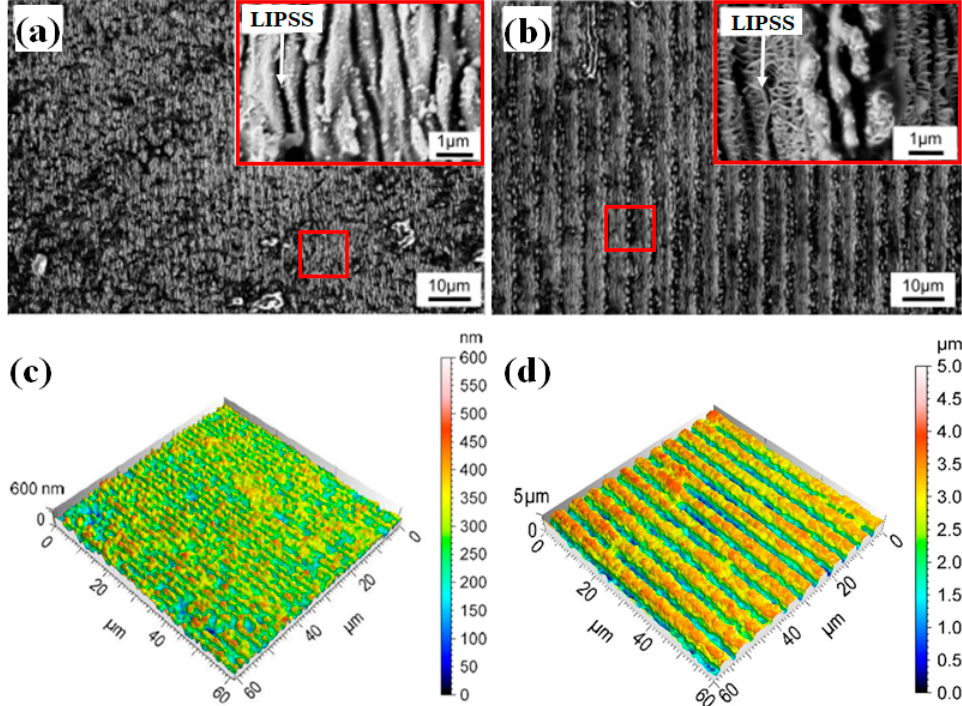
Figure 3. SEM images of DLIP textured cutting insert ( Λ = 2.0 µm, NP = 40) ( a ), SEM images of